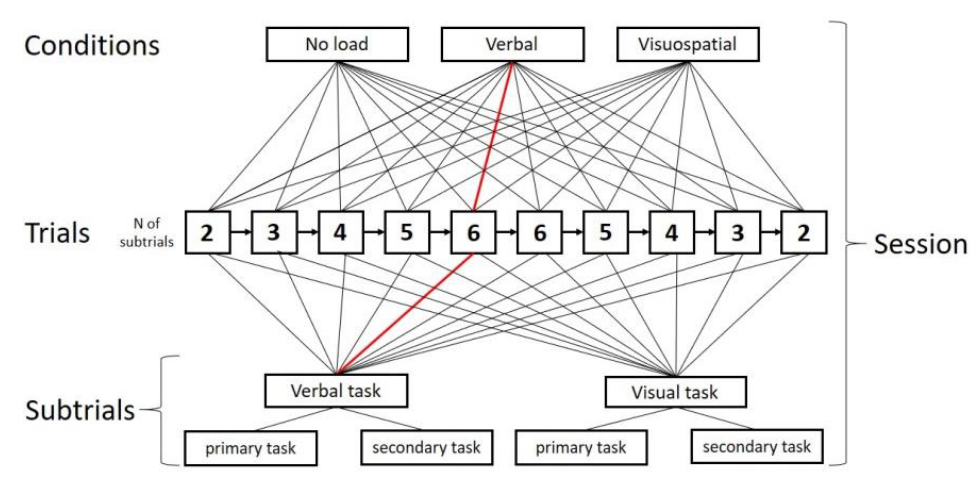
Figure 2. The experimental session scheme. The marked line is an example of a random trial that included six verbal sub-trials in verbal cognitive load condition.